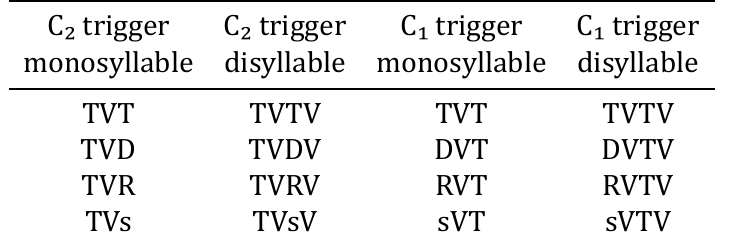
Table 5: Dataset. T = fortis stop; D = lenis stop; R =